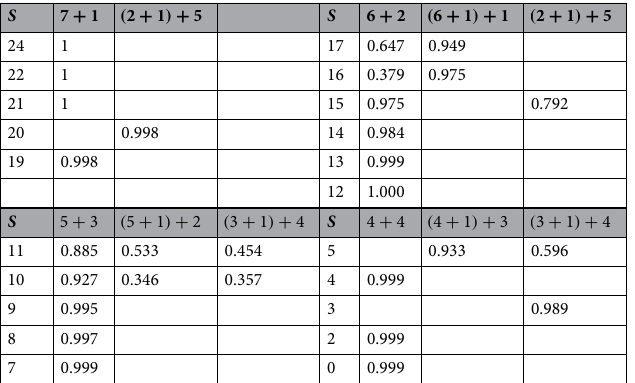
Table 1. The overlaps � ( [ N 1 ][ N 2 ] ) S | � S ,1 � ( N 1 + N 2 in short) and � ( [ N ′ 1 ] χ) 3 N ′